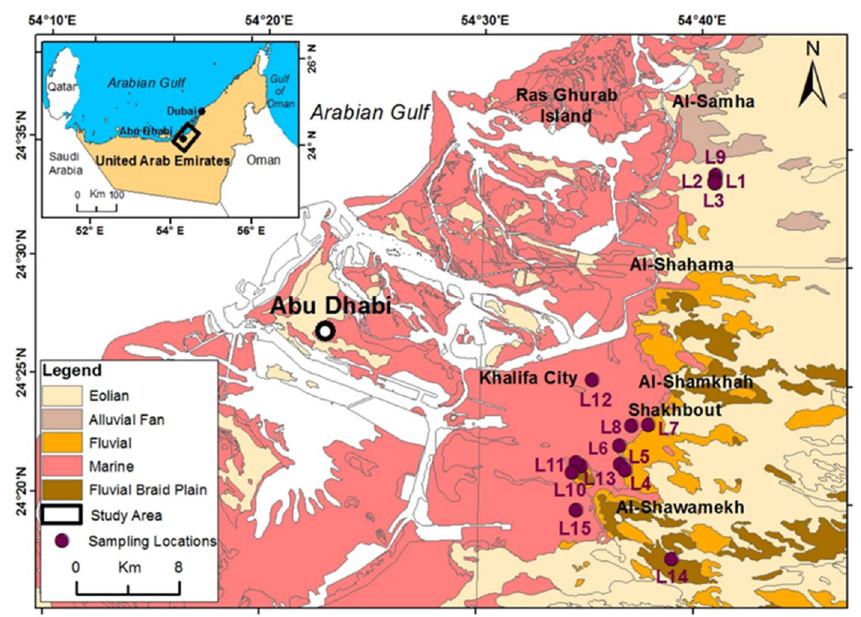
Figure 1. Geological map of the study area and sampling locations (generated with ArcGIS 10.8 27 ).